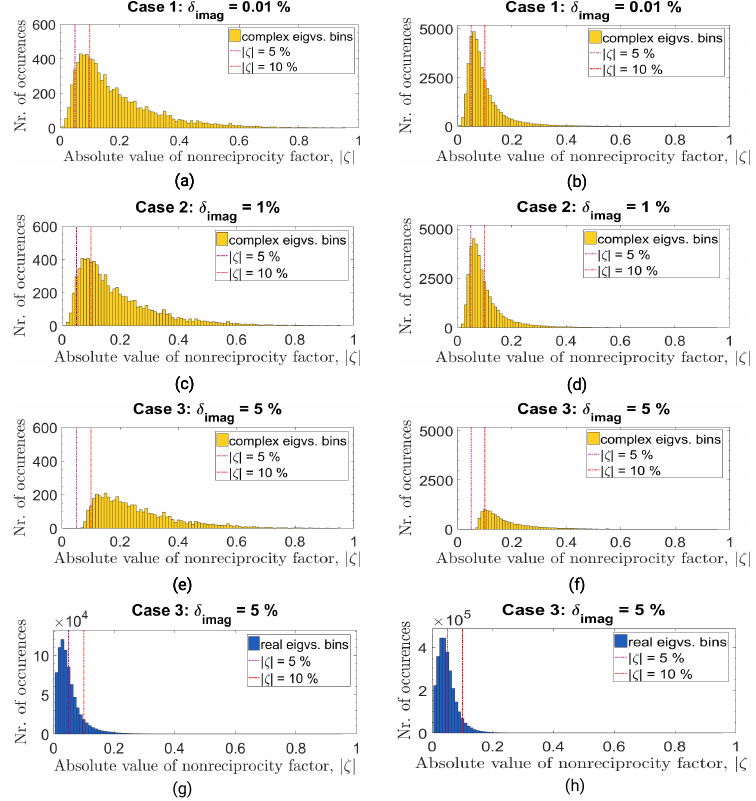
Figure 2. Convair Ottawa results ( left ); Convair Ice results ( right ); ( a , c , e ) Changes in the distribu- tion of NRF absolute values for the RRSMs returning complex eigenvalues (yellow color), intro- duced by varying δ imag -Convair Ottawa data. ( b , d , f ) Same as with ( a , c , e ), but for Convair Ice data. ( g ) Distribution of NRF absolute values for RRSMs returning real eigenvalues (blue color), when δ imag = 5%-Convair Ottawa data. ( h ) Same as ( g ), for Convair Ice data. Table 3. Variations in the distribution of RRSM eigenvalues type, with changes in the values of δ imag , for two monostatic real PolSAR dataset (Convair Ottawa and Convair Ice). Real Eigvs. Pairs [%] Complex Real Eigvs. Pairs [%]